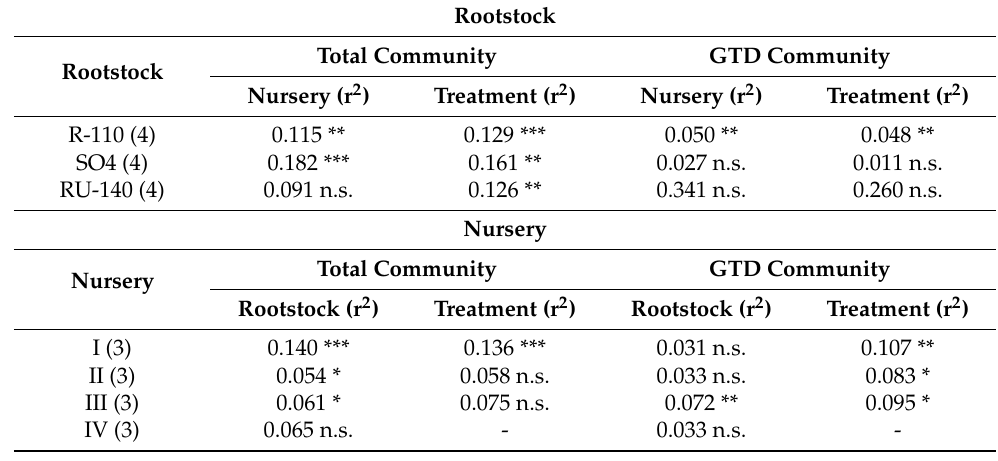
Figure 5. PCoA ordinations calculated with a Bray-distance matrix showing the contribution of nurseries I ( top ) and II ( bottom ) to total fungal community structures ( left ) and GTD community structures ( middle ) for each treatment in graft unions. The R 2 and p -values shown are extracted from a PERMANOVA analysis performed with the adonis2 function in R. The biomass accumulation (g) of plants in 2020 and 2021 that originated from nurseries I and II ( right ) is shown on the right. Table 6. Contribution of each rootstock (top) to variation (r 2 ) by nursery and treatment for total and GTD communities in root collars and of each nursery of origin (bottom) to variation (r 2 ) by rootstock and treatment. The annotation following the r 2 value indicates the significance level: *** <0.001, ** <0.01, * <0.05, n.s. = not significant (>0.05). Numbers in parentheses in indicate the number of nurseries that supplied a particular rootstock (top) and the number of rootstocks supplied by each nursery